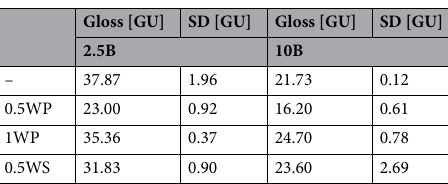
Table 6. The gloss of composites conditioned at room